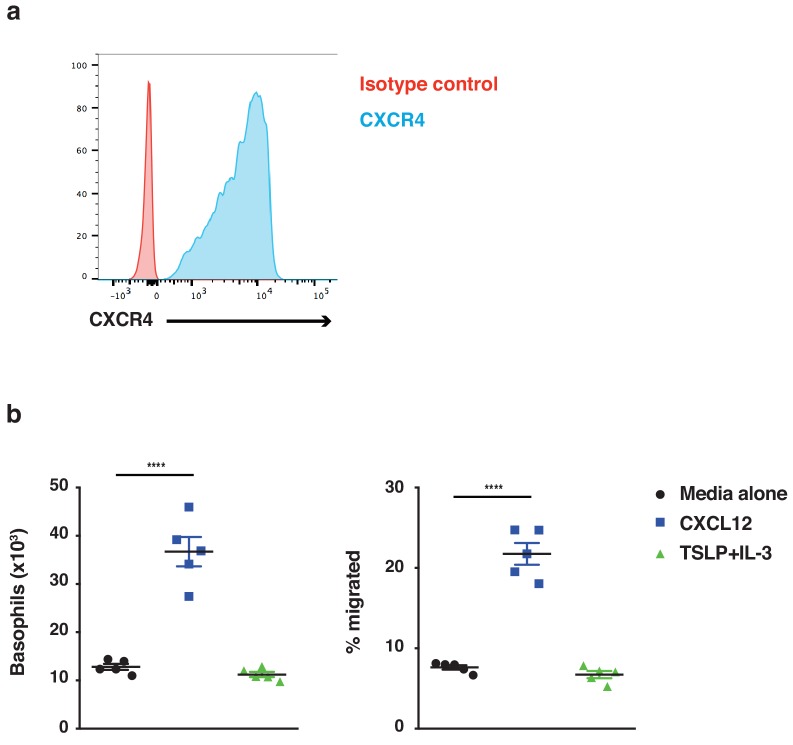
Basophils demonstrate chemotaxis towards CXCL12.Basophils were cultured from bone marrow (n = 5) and FACS sorted on day 14 of culture as CD45+cKit–FcεRI+ cells. (a) Basophils were stained for expression of the CXCR4 receptor (representative histogram shown) and (b) assessed for chemotaxis towards CXCL12 using transwells. Data are expressed as absolute numbers of basophils migrated and as % migrated basophils ± SEM (n = 5). Statistical analysis was performed by one-way ANOVA multiple comparison; ****p<0.0001.